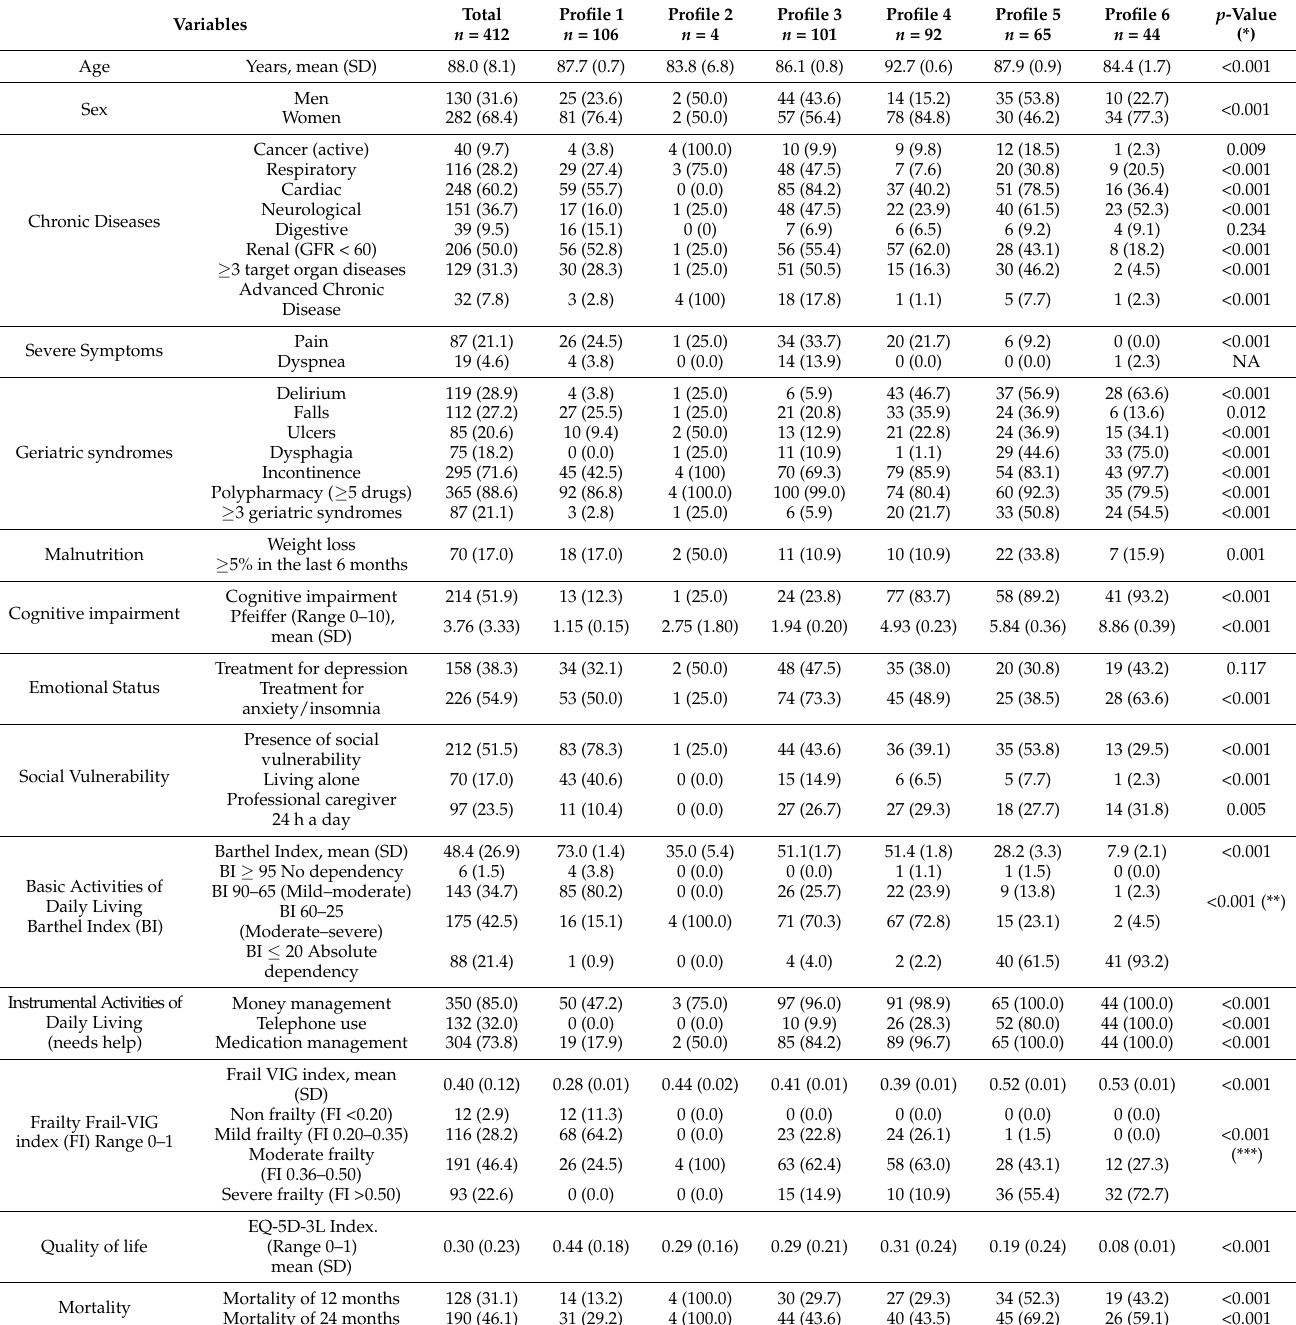
Table 1. Characteristics of participants in each of the six profiles identified through cluster analysis. Values are absolute frequencies (percentages) unless stated